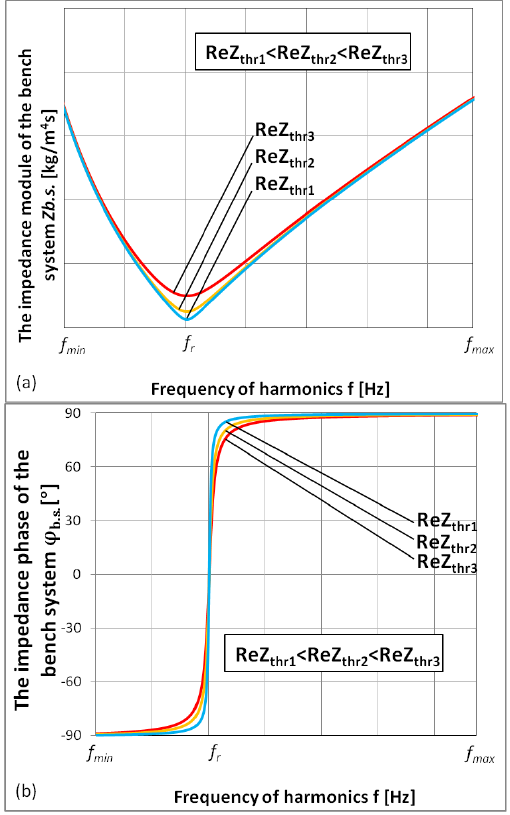
Figure 20. Impedance of the bench system with a cavity at the pump output: ( a ) impedance module and ( b ) impedance phase. Analysis of Figure 20: